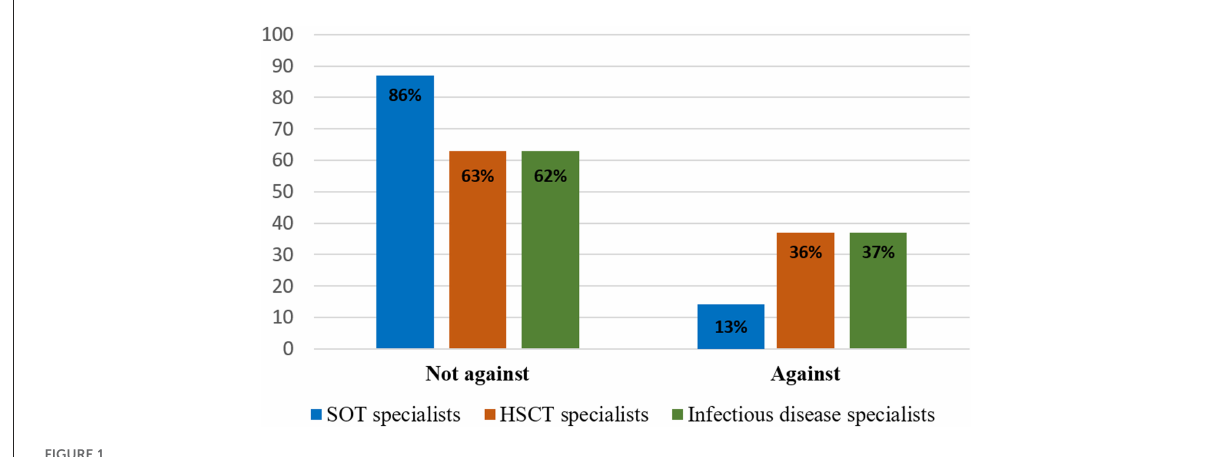
FIGURE1 Recommendations given regarding pet ownership according to the various specialists.